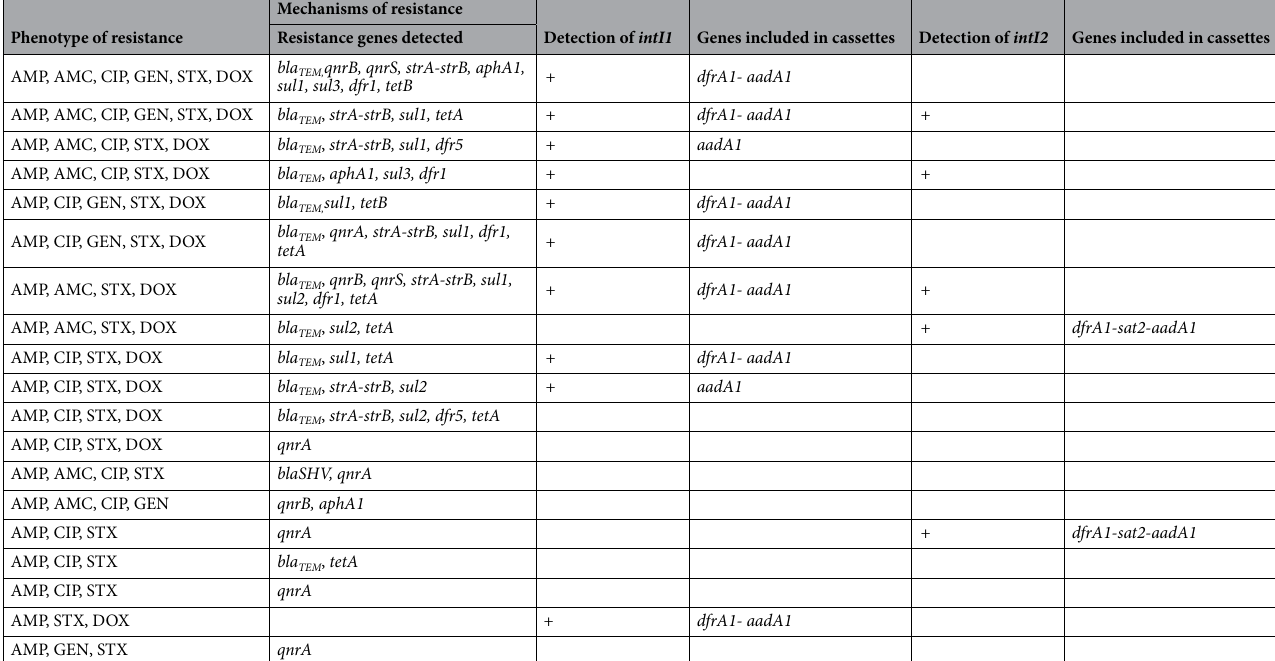
Table 5. Phenotypes, antibiotic resistance and prevalence of class 1 and 2 integrons, detected in 19 MDR E. coli isolates obtained from meat (Group